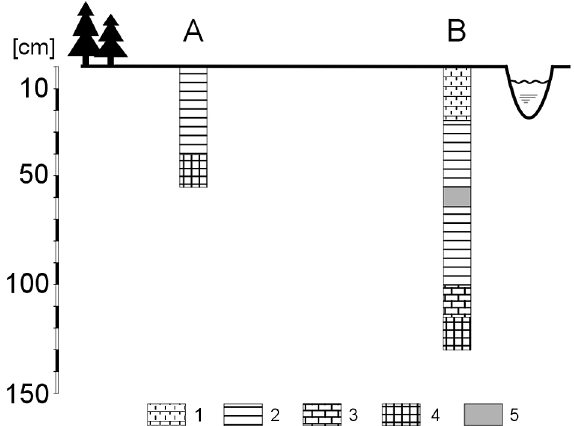
Fig. 2. Structure of organic deposit in marginal zone (A) and central zone (B) of the Chwiszczej river valley. 1 – muck, 2 – moderately decomposed sedge peat, 3 – well-decom- posed sedge peat, 4 – sanded peat, 5 – sedge-alder peat.